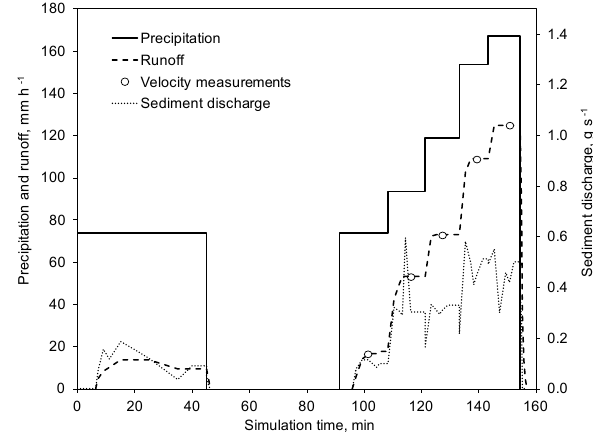
Figure 2. Breakthrough curve of electrolyte solution in runoff at 150mmh − 1 rainfall intensity.